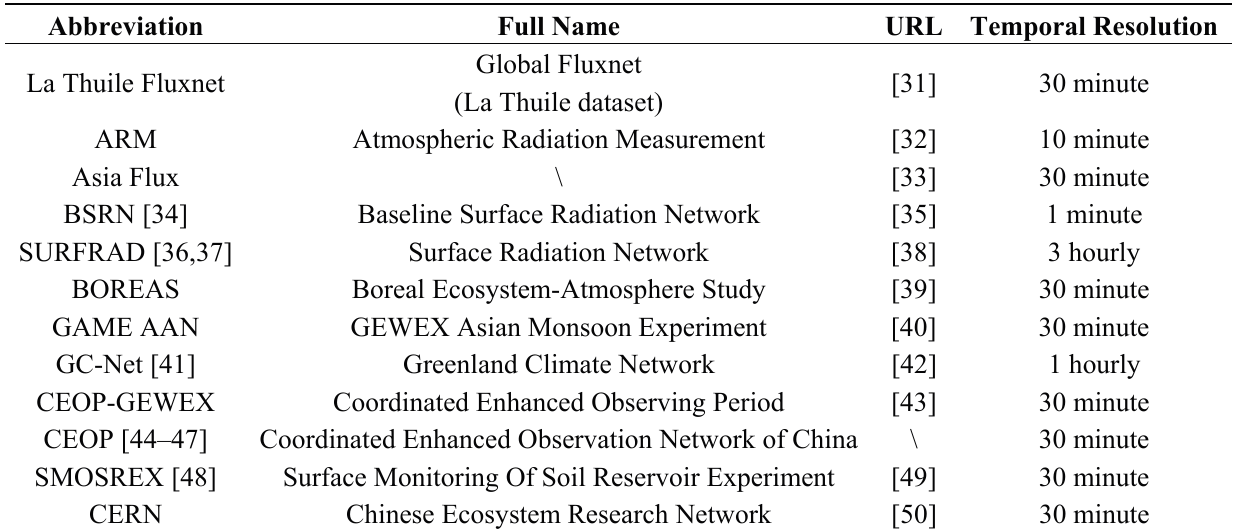
Table 1. Information related to the 12 measurement networks.